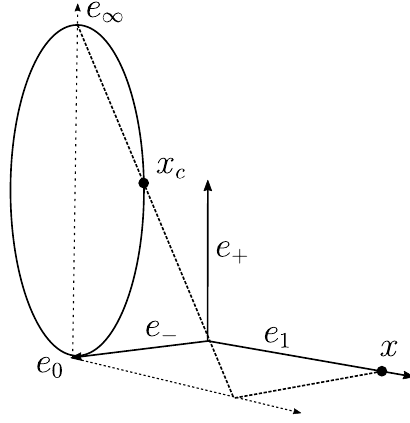
Figure 1. Homogeneous stereographic